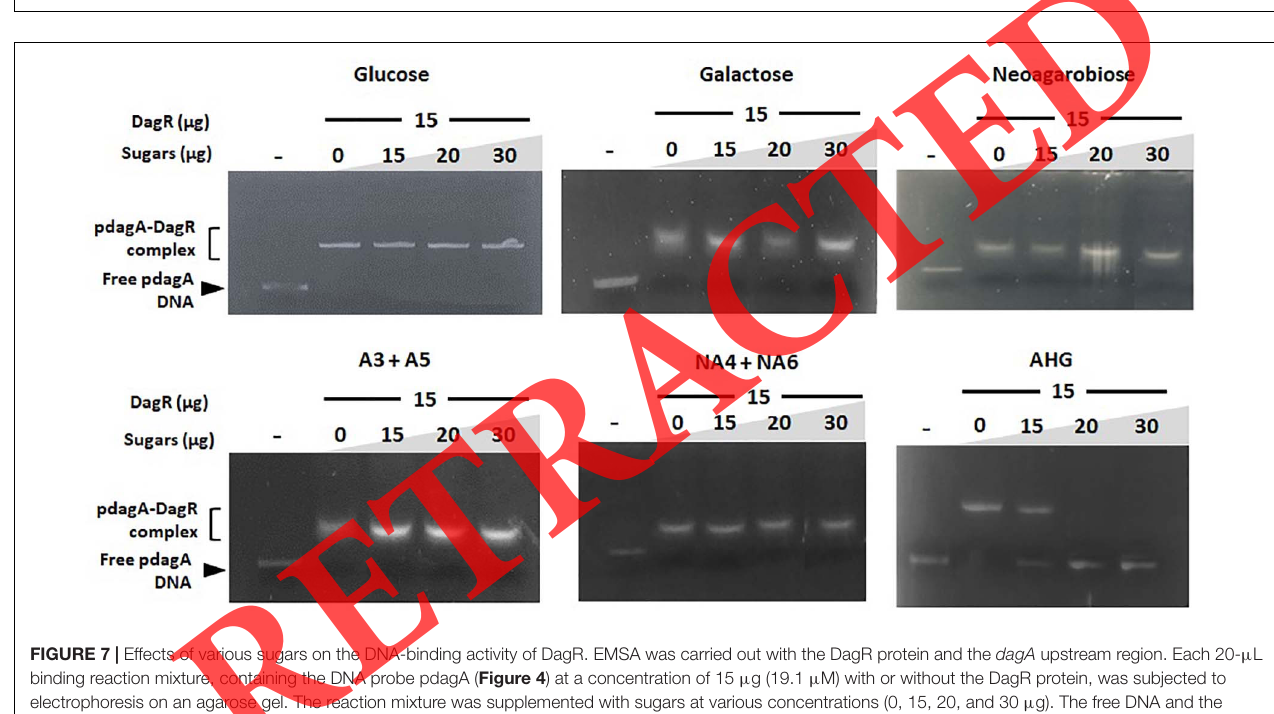
FIGURE 7 | Effects of various sugars on the DNA-binding activity of DagR. EMSA was carried out with the DagR protein and the dagA upstream region. Each 20- µ L binding reaction mixture, containing the DNA probe pdagA ( Figure 4 ) at a concentration of 15 µ g (19.1 µ M) with or without the DagR protein, was subjected to electrophoresis on an agarose gel. The reaction mixture was supplemented with sugars at various concentrations (0, 15, 20, and 30 µ g). The free DNA and the DNA-protein complex are indicated by parentheses and black arrowheads,